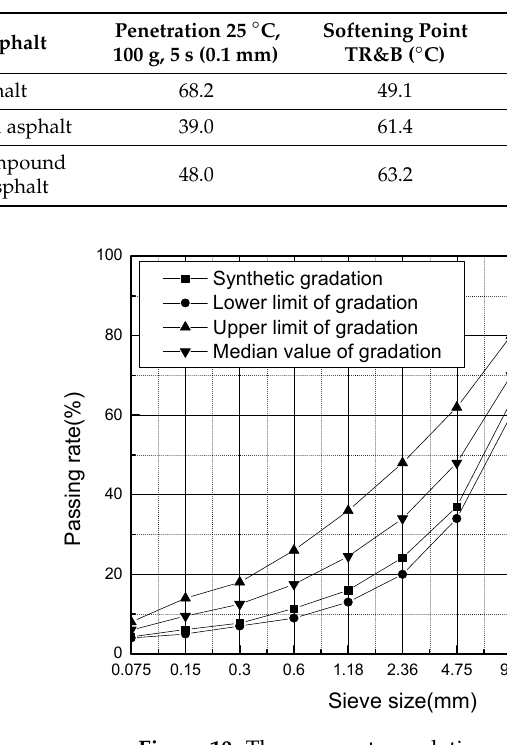
Table 20. Performance Index of BRA–SBR composite modified asphalt.